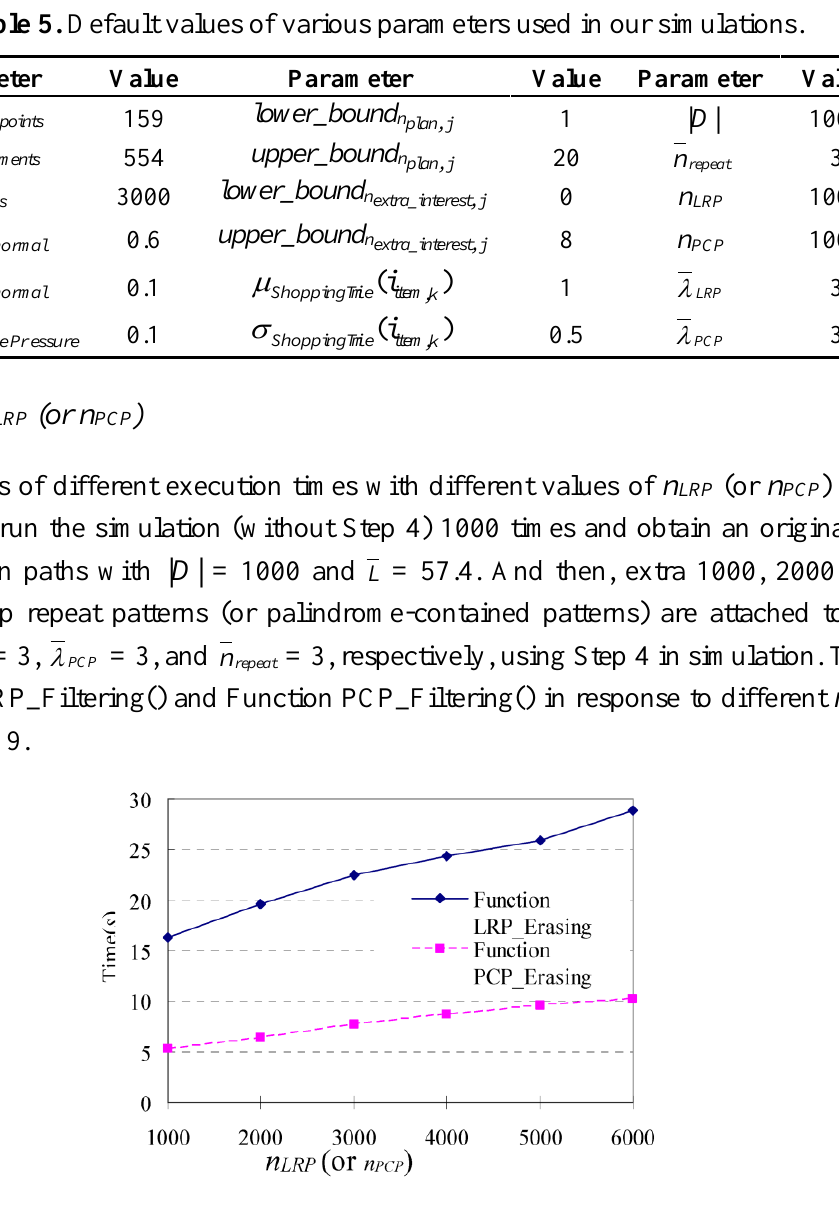
Figure 9. Execution time in response to changes in different n LRP (or n PCP